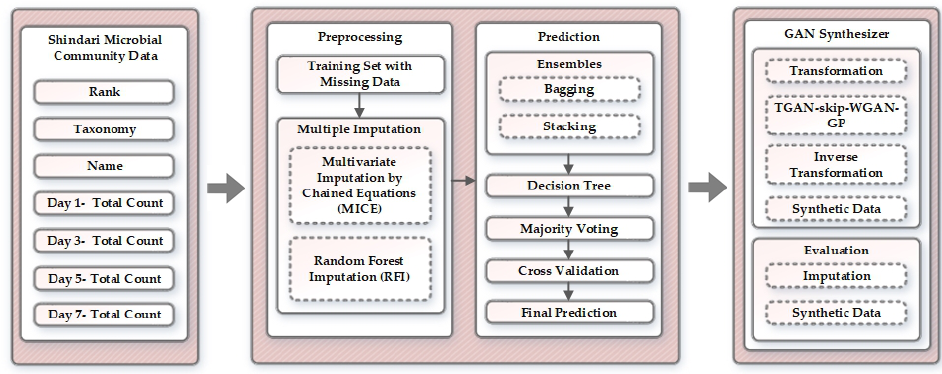
Figure 1. Overview of the proposed